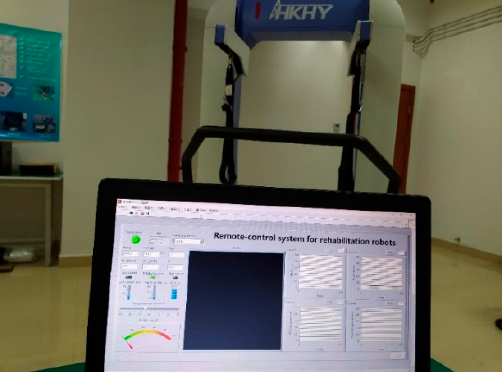
Figure 12. Communication success diagram of the rehabilitation robot client computer.